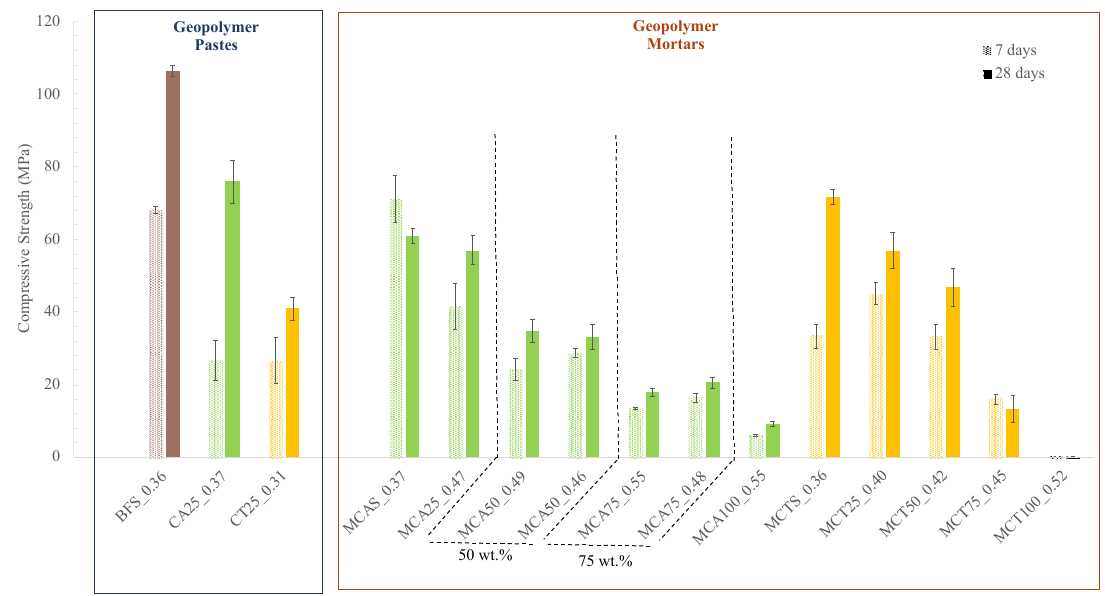
Figure 7. Compressive strength of the hardened samples after 7 and 28 days of curing.